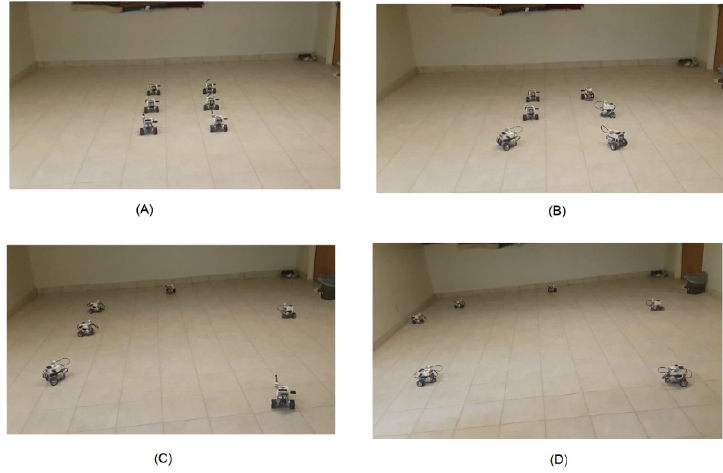
Figure 15. Repulsive force test using six EV3 robots. ( A ) The initial position of the robots. ( B ) Robots after moving one step. ( C ) Robots after moving another step. ( D ) Final deployment.